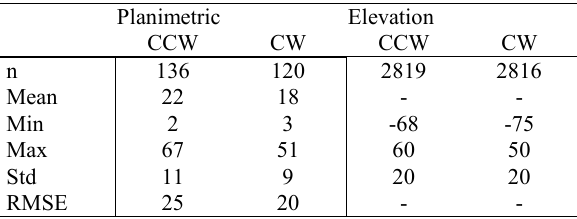
Table 2. Accuracy of the ROAMER data, units in